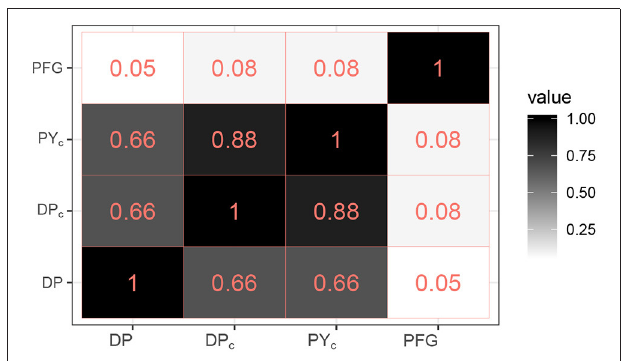
FIGURE 2 | Pairwise ARI similarities between the PFGs and the clusters estimated by the models ( DP , DP c , PY c ).